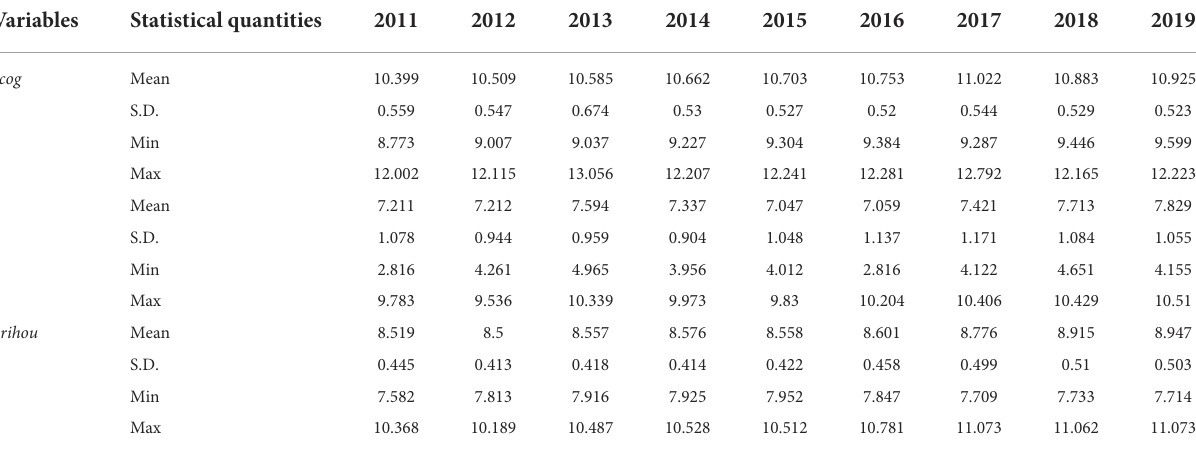
TABLE 2 Descriptive statistics of main